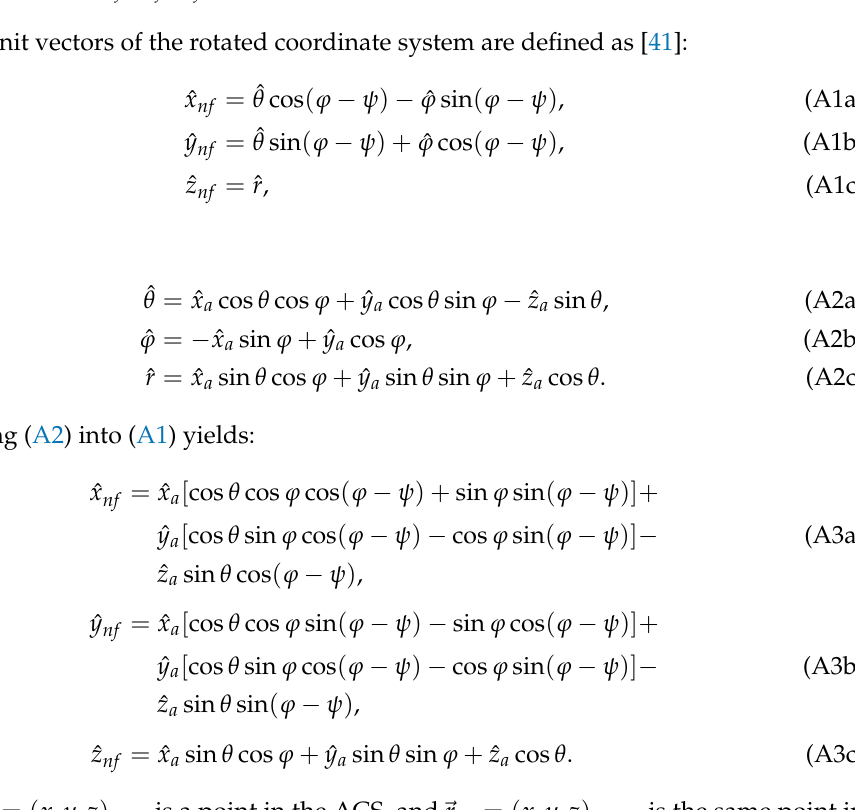
Figure A1. Rotation of the array coordinate system (ACS) ( ˆ x a , ˆ y a , ˆ z a ) to obtain the near field coordi- nate system (NFCS) ( ˆ x nf , ˆ y nf , ˆ z nf ) . This rotation is specified by angles θ , ϕ , and ψ